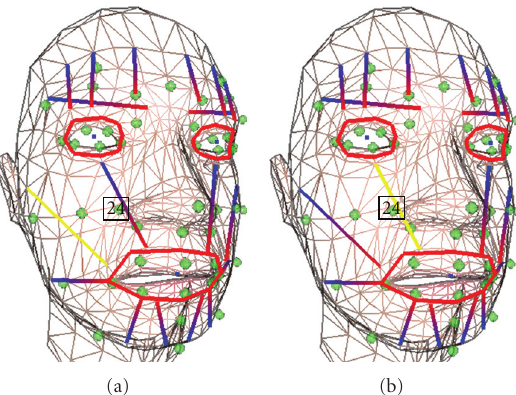
Figure 9: Facial muscle registration. The control point (index 24) is influence by two linear muscles. (a) Right levator (RI = 0.756, AI = 0.825), and (b) right zygomaticus major (RI = 0.951, AI = 0.468).